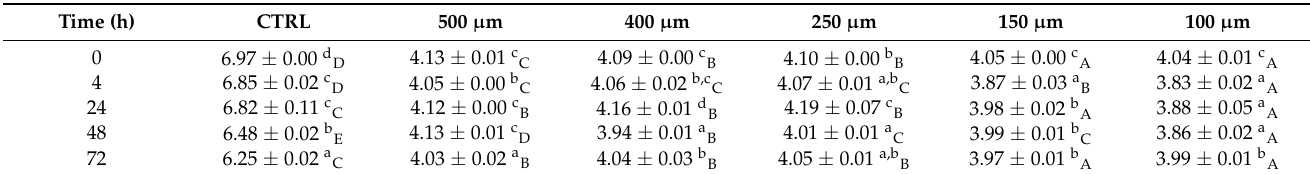
Table 3. Values of pH for broths inoculated with yeasts, with and without PPP.